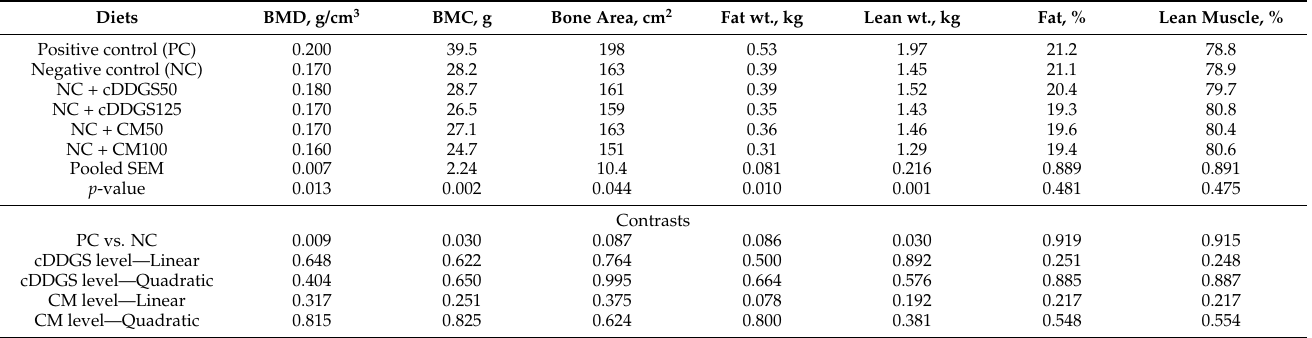
Table 10. Whole body composition (d 42) of broilers receiving diets containing soybean with reduction in crude protein or low-protein diets with serial inclusion levels of canola meal or corn–DDGS supplemented with crystalline amino